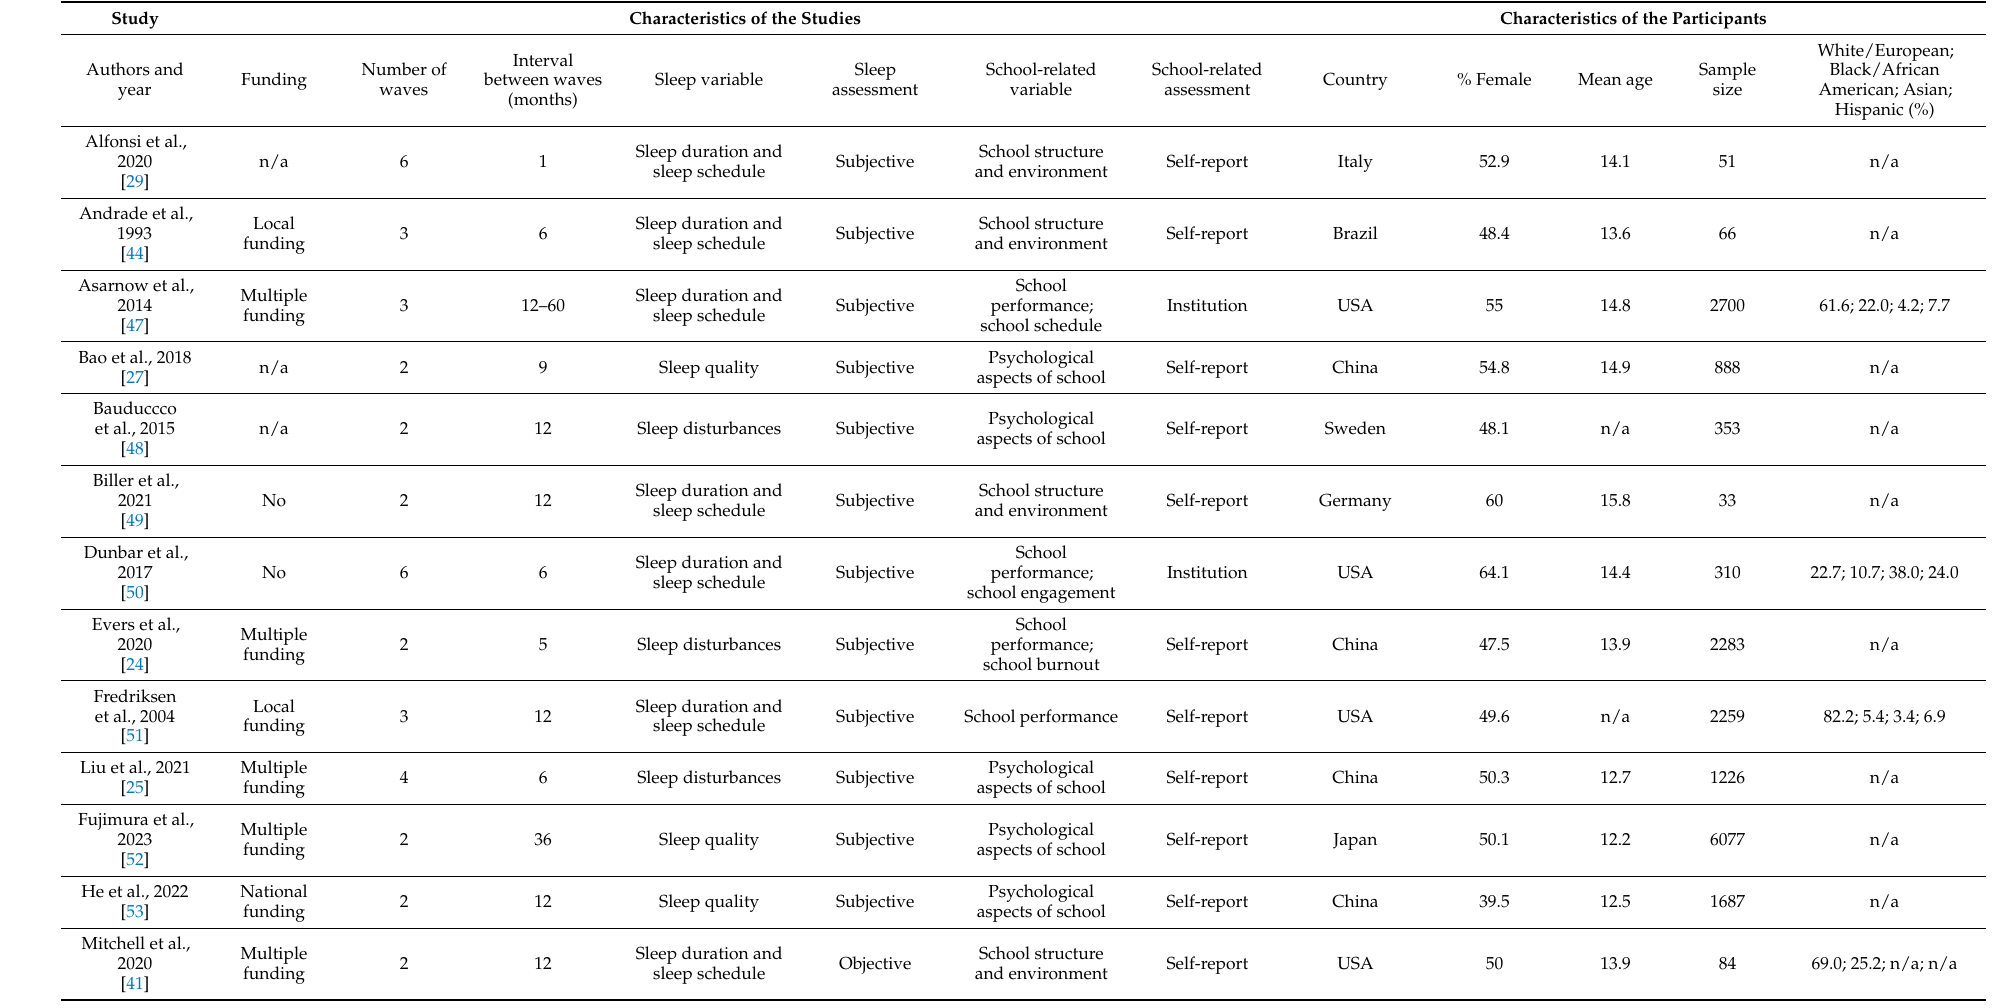
Table 2. Characteristics of